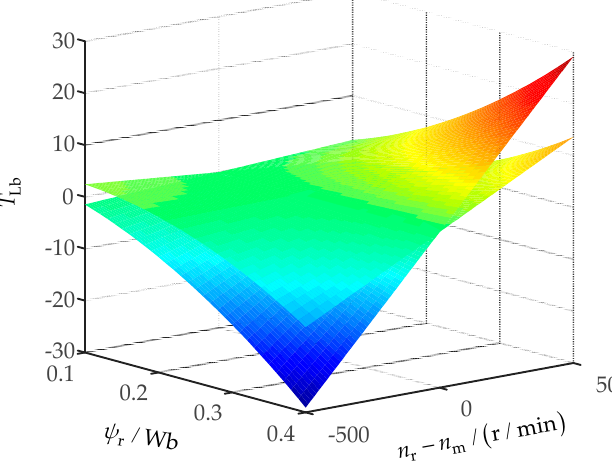
Figure 5. The upper and lower boundaries of load torque.